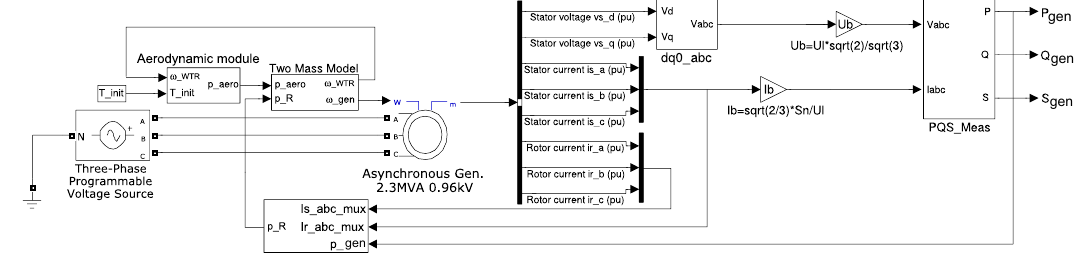
Figure 4. Type 1A WT